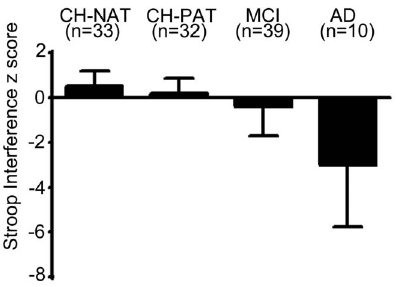
Figure 3. Stroop Interference z scores by clinical group. Mean (SD) Stroop Interference z scores for the CH-NAT, CH-PAT, MCI, and AD groups (the Stroop Interference test was not administered to many of the AD